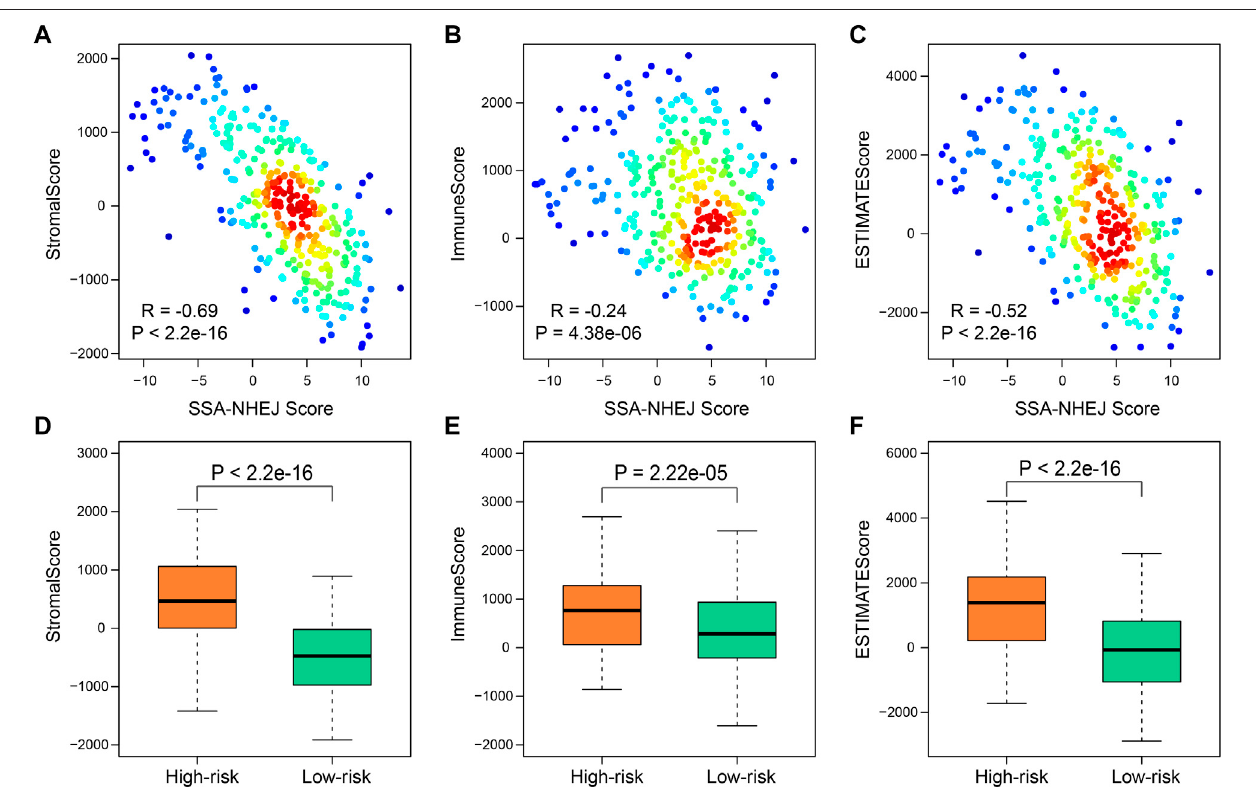
FIGURE6| Immune-relatedscoreby “ estimate ” . (A – C) CorrelationbetweenSSA-NHEJscoreandStromalScore (A) ,ImmuneScore (B) ,andESTIMATEScore (C) in TCGA samples. R and P were calculated by the Pearson test. (D – F) Low-risk samples have lower StromalScore (D) , ImmuneScore (E) , and ESTIMATEScore (F) compared with high-risk samples. p values were calculated by Wilcoxon